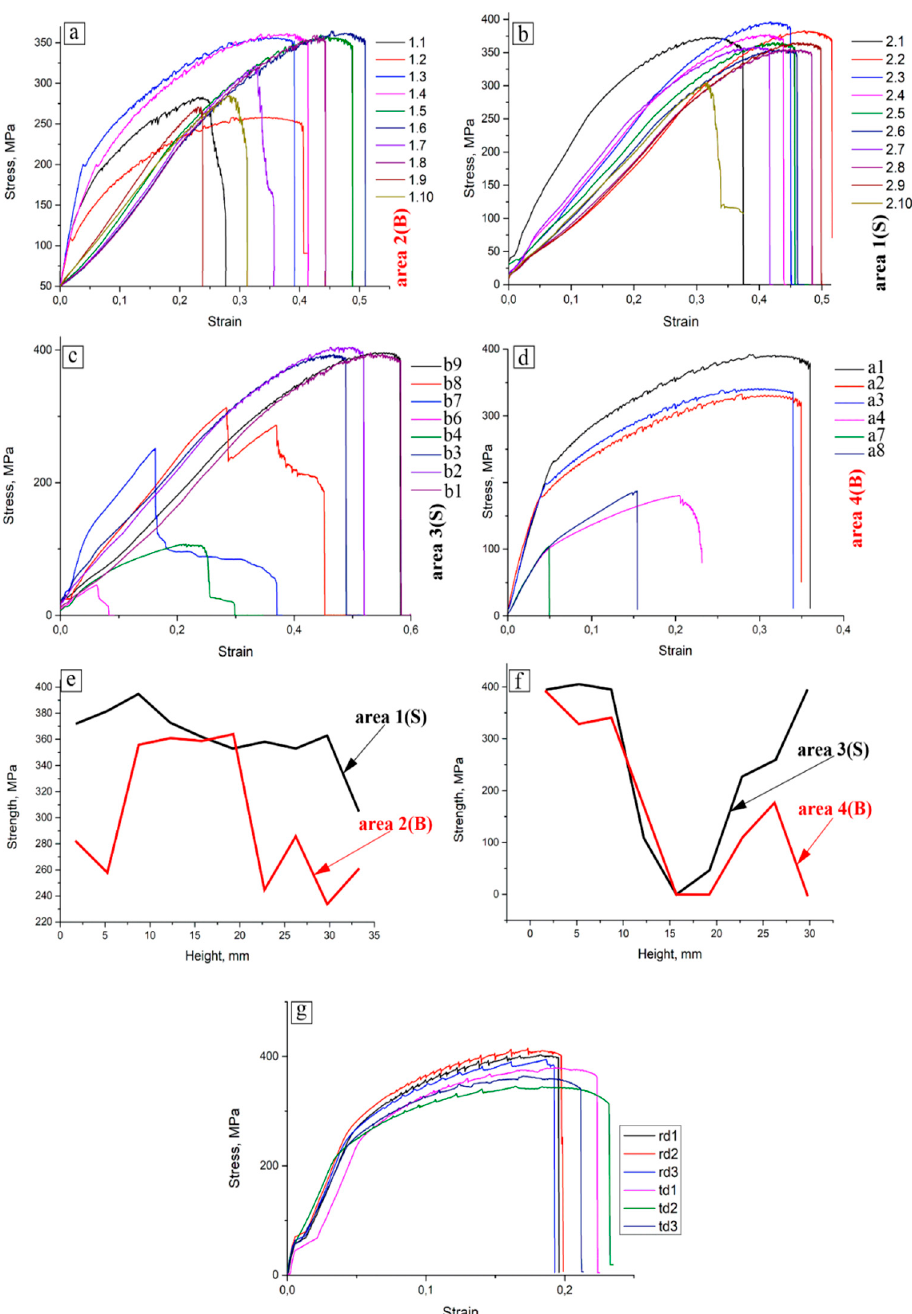
Figure 11. Mechanical properties of specimens cut across the weld at different distances from the weld root for 35 mm-thick ( a , b ) and 30 mm-thick ( c , d ) plates, the dependence of the mechanical properties on the distance from the weld root for 35 mm-thick ( e ) and 30 mm-thick ( f ) plates in zones “B” and “S” (see Figure 1 ), and the test diagrams of the base metal tested along and across the rolling direction ( g